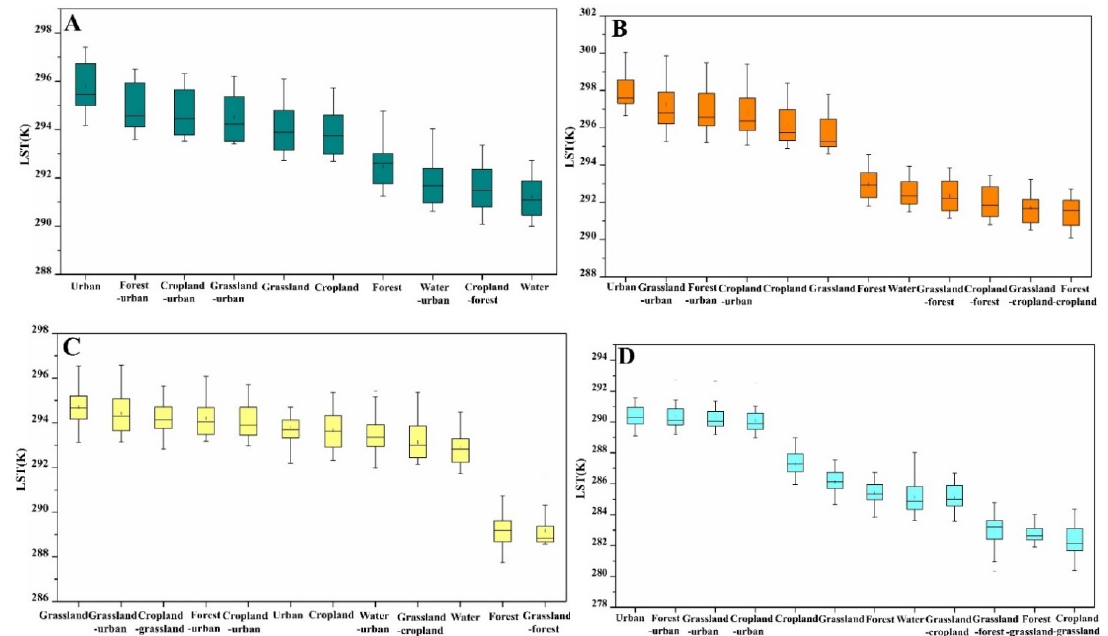
Figure 5. Statistical characteristic values of land surface temperature based on different land types from 2000 to 2015 (( A ) Jinan City, ( B ) Zhengzhou City, ( C ) Lanzhou City, ( D ) Xining City. LST here is in kelvin).